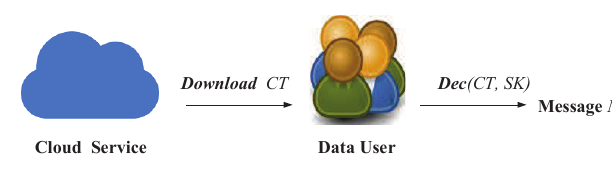
Figure 6. Ciphertext